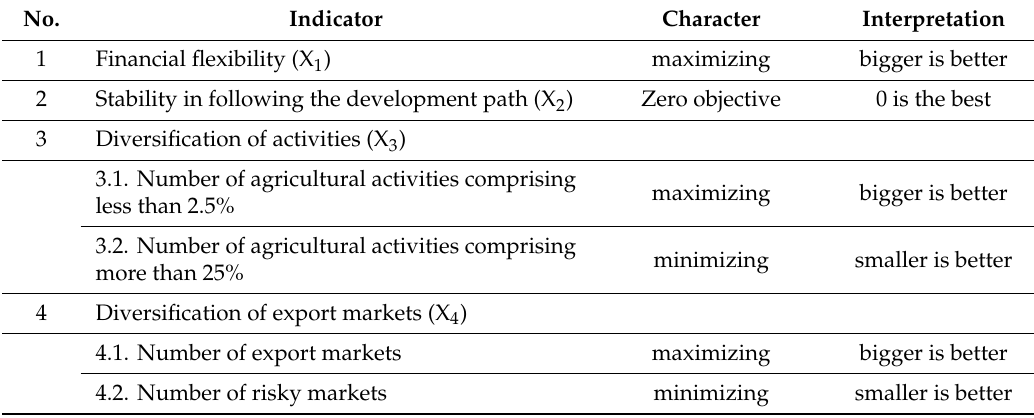
Table 2. Indicators used in an assessment of economic resilience of Austrian